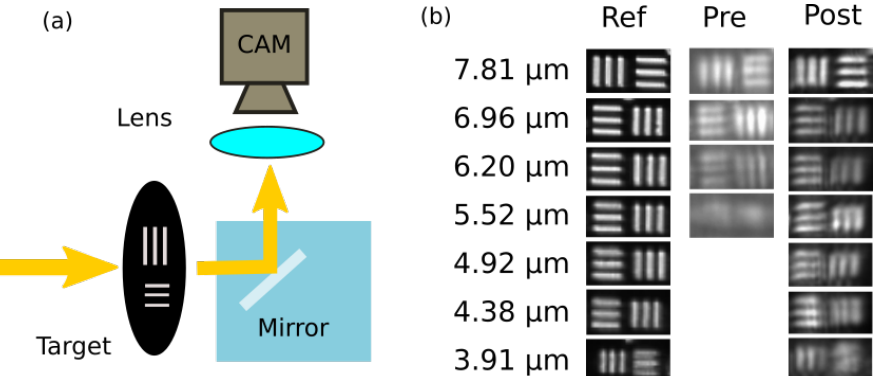
Figure 3. Optical performances comparison: ( a ) scheme of the experiment; ( b ) comparison of USAF- 1951 target images, between the reference (Ref), not-treated mirror (Pre), and smoothed mirror (Post). A blurring effect is evident, induced by the residual roughness in the images from not-treated mirrors that contribute to increasing the background and to reducing the